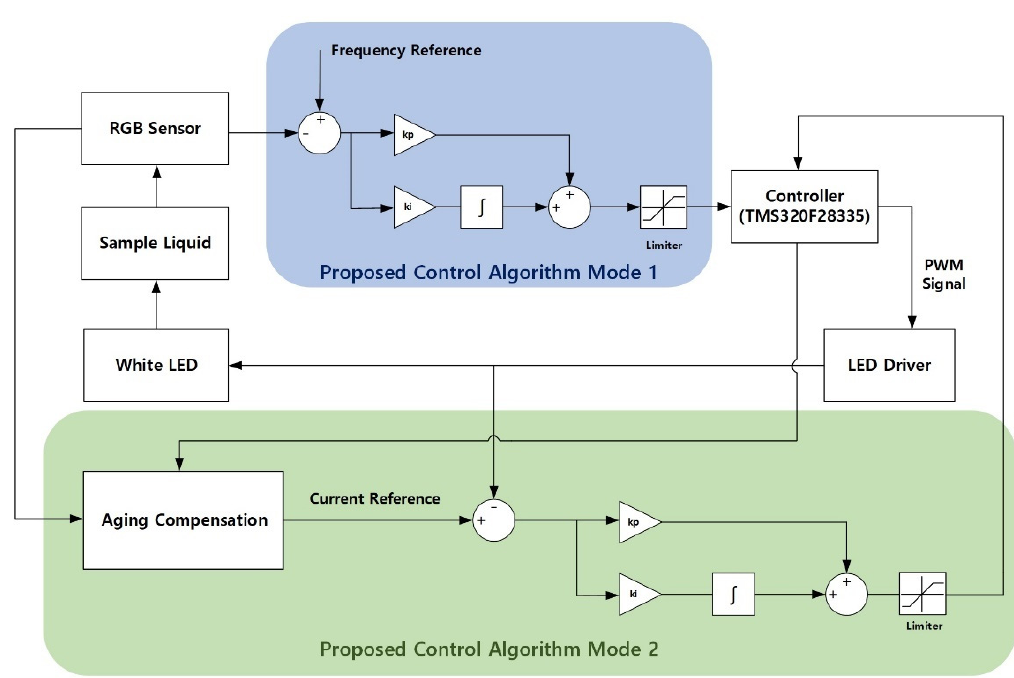
Figure 3. Proposed Control Algorithm for LED module calibration.